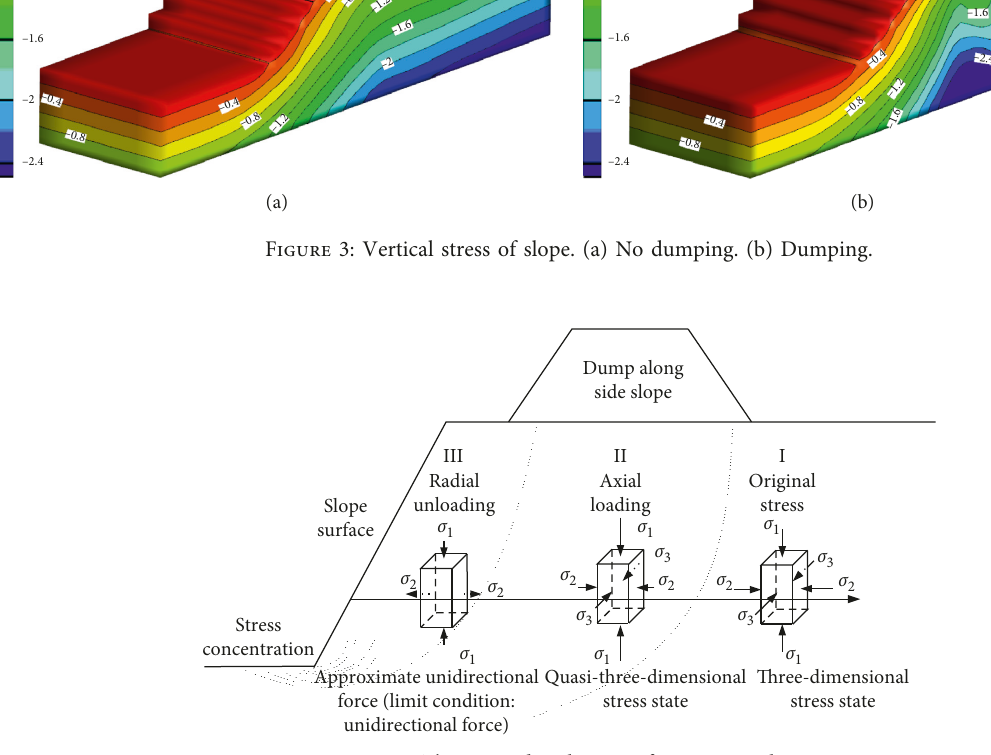
Figure 4: The stress distribution of composite